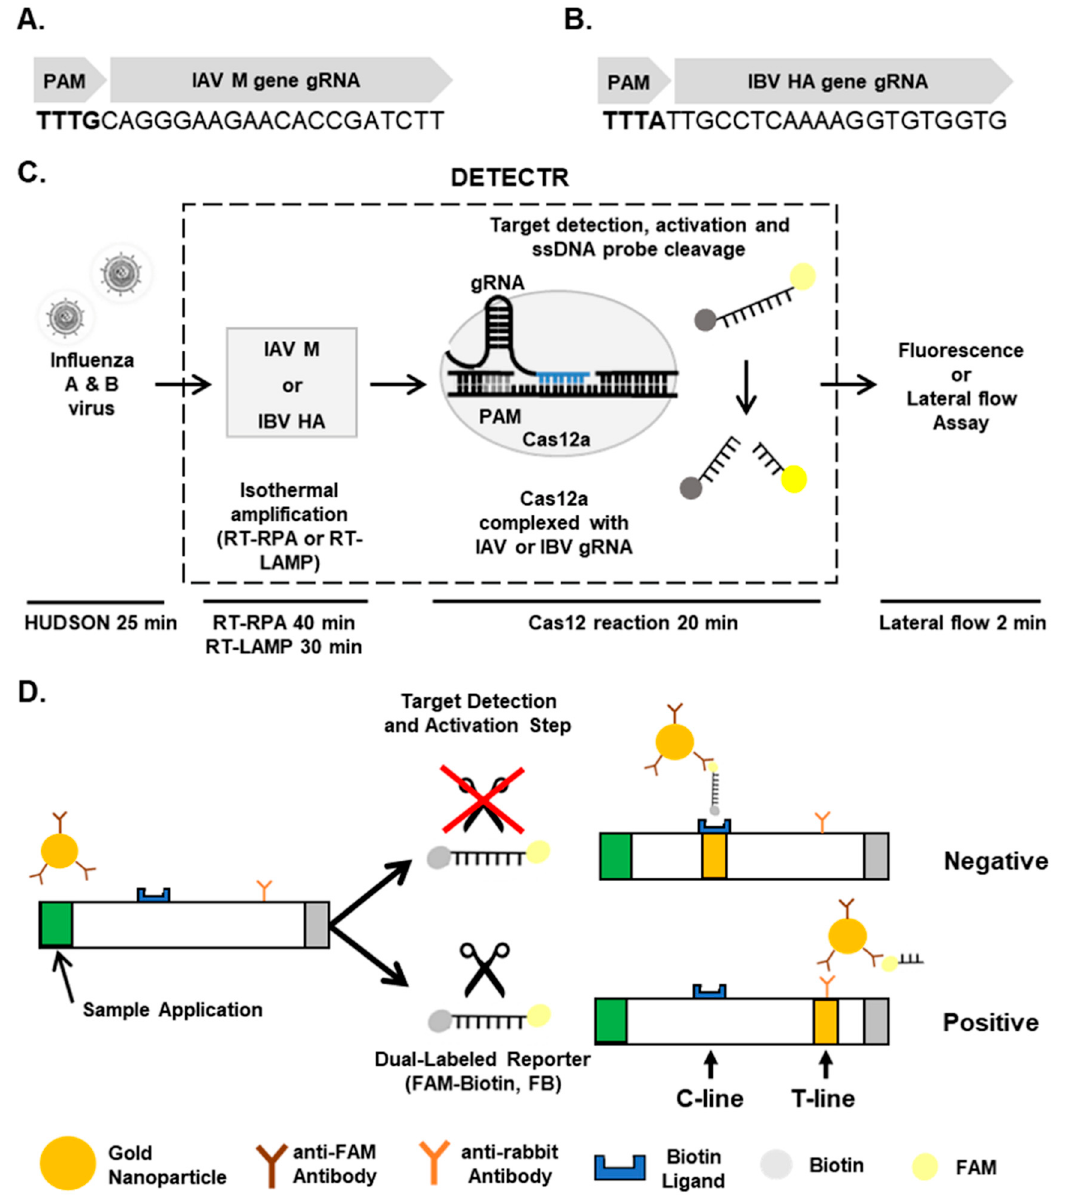
Figure 1. Detection of influenza virus types using CRISPR-Cas12a. ( A , B ) gRNAs for targeting IAV Matrix ( A ) and IBV HA ( B ) genes. ( C ) Workflow for detecting IAV and IBV by CRISPR-Cas12-based DETECTR combined with a fluorescence or lateral flow assay. ( D ) Schematic diagram showing how to distinguish between positive and negative results in a lateral flow strip. FB, FAM-Biotin; C-line, control line; T-line, test line.